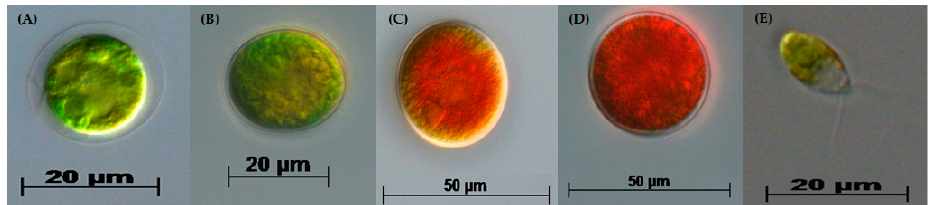
Figure 1. Life cycle stages of H. pluvialis : ( A ) green motile macrozooid, ( B ) early stage palmelloid, ( C ) late-stage palmelloid, ( D ) aplanospore (haematocyst) and ( E ) green motile microzooid.